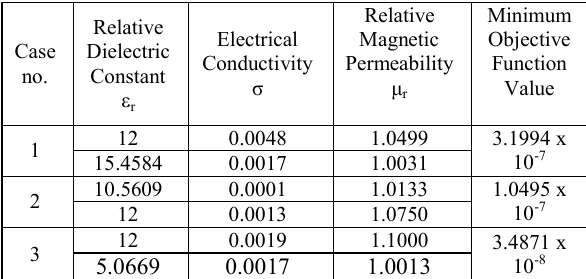
Table 4: Estimated Physical Properties of each layer of the three case studies after the inversion